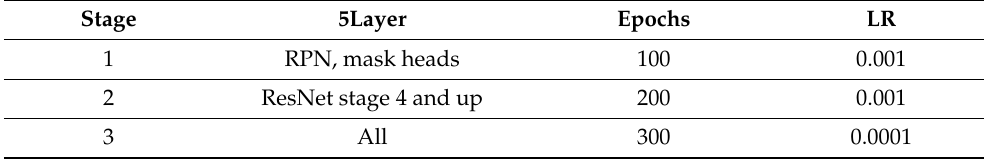
Table 5. Detail of the training process.